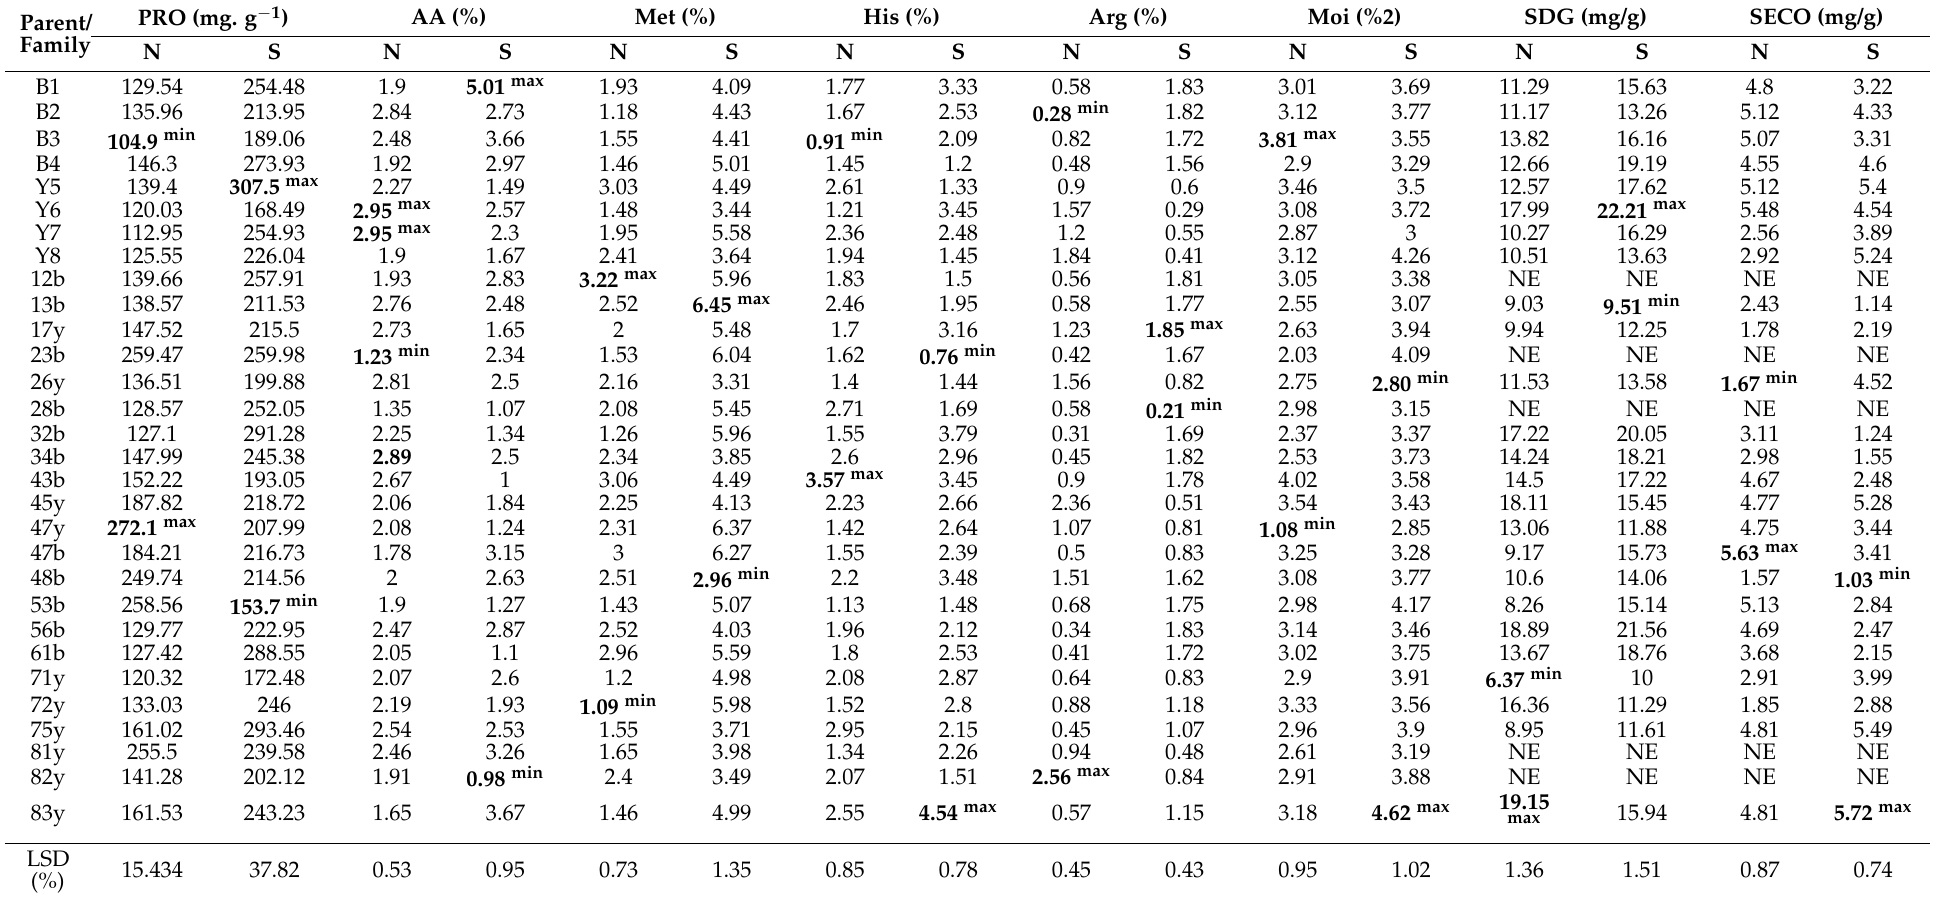
Table 5. Means of quality traits (NIR) and lignans in parents and families of flax under control and intense drought stress